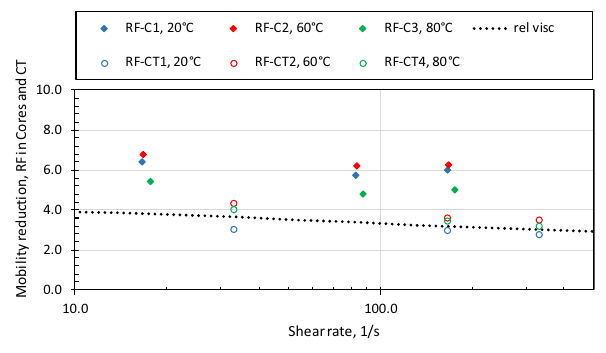
Fig. 9 Experiment 1b. RF pm and RF CT and as a function of shear rate in the Bentheimer cores and capillary tubes (CT) for 1000 ppm A06 in SSW. Blue markers are used for 20 °C, red for 60 °C and green for 80 °C. The markers for the cores are filled diamonds and the mark- ers for the capillary tubes are open circles. The dashed line shows the relative viscosity of 1000 ppm A06 in SSW from the Carreau model (Eq. 4) fitted to measurements performed with Anton Paar Rheometer at 20 °C